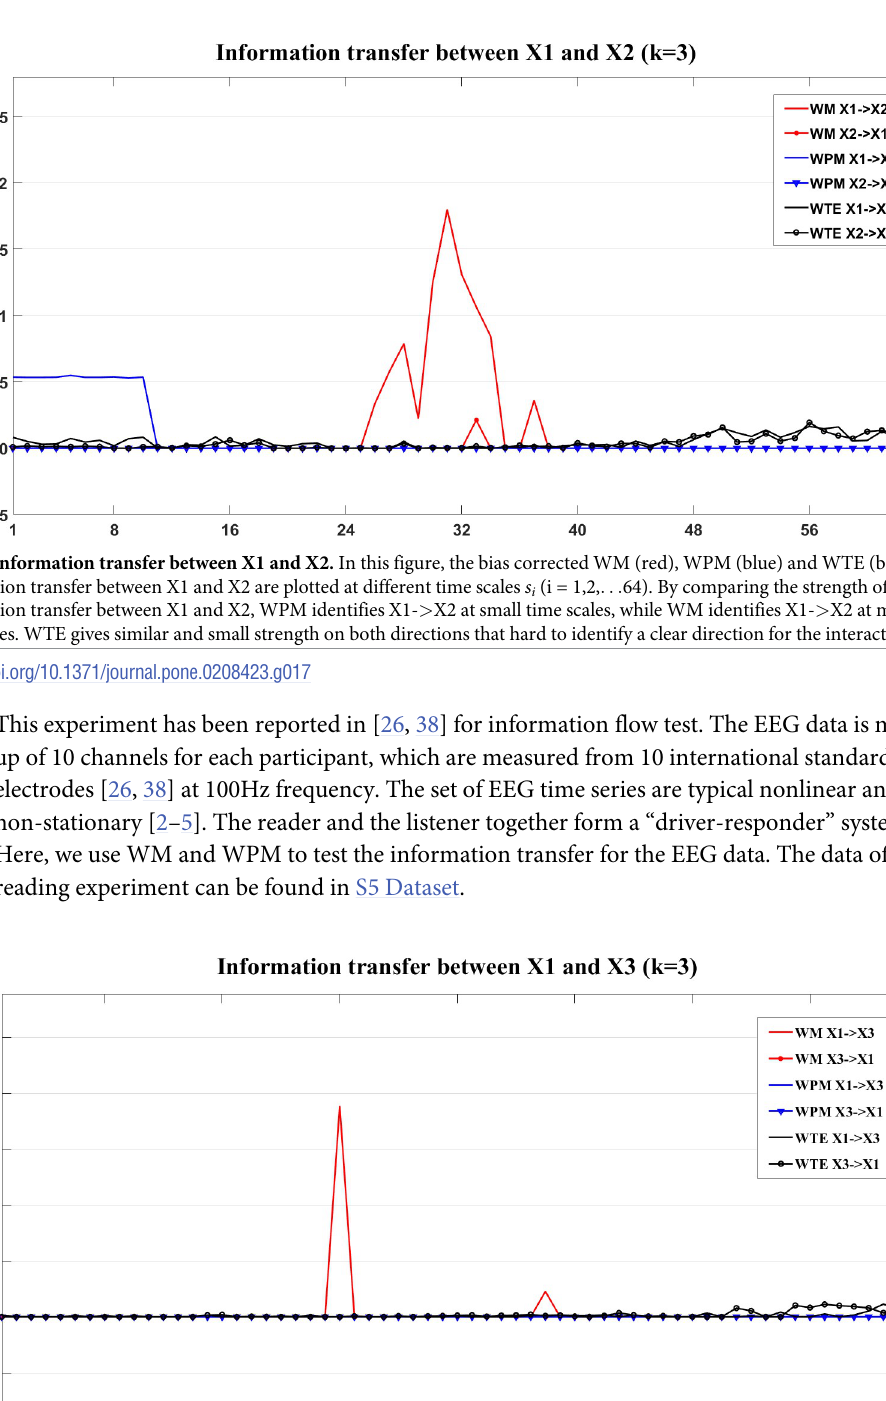
(i = 1,2, ... 64). By comparing the strength between i